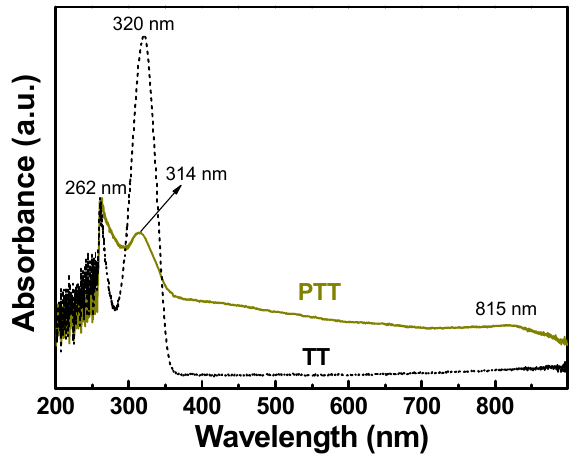
Figure 1. UV-Vis absorption spectra of the TT monomer and PTT polymer prepared with the CuCl 2 /TT molar ratio of 1.0 and the TT concentration of 0.38 mol·L − 1 in dimethylformamide (DMF) at molar ratio of 1.0 and the TT concentration of 0.38 mol · L − 1 in dimethylformamide (DMF) at 25 ◦ C for 25 °C for 24 h. 24